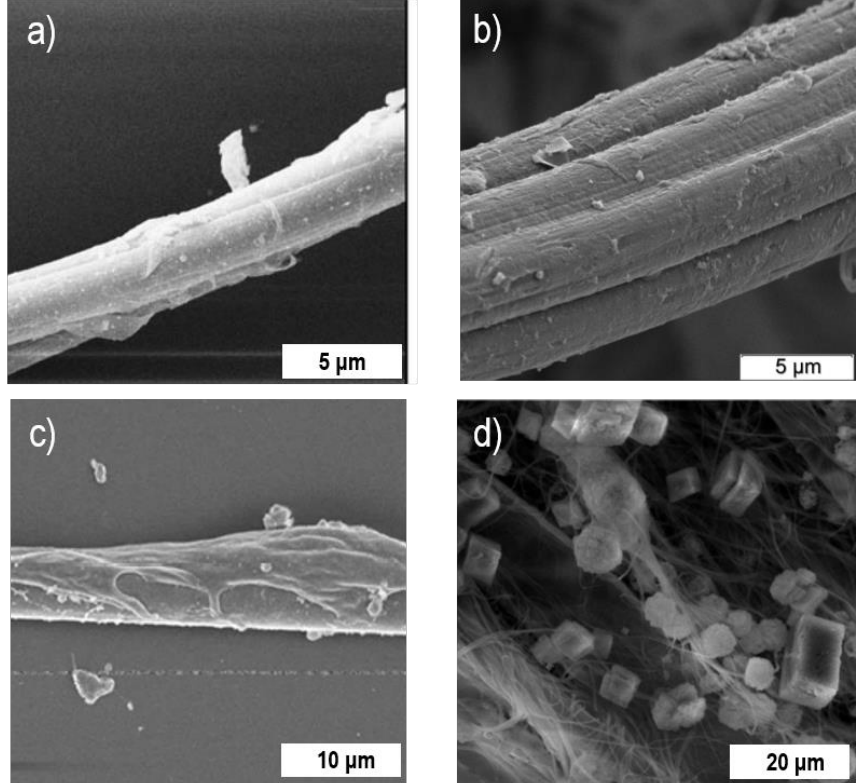
Figure 3. Scanning electron micrographs of spider silk fibers modified with: ( a ) metal nanoparticles (Au) [72], Reproduced with permission from [72]. John Wiley and Sons, 2007. ( b ) metal oxide nanoparticles (ZrO 2 ) [84], Reproduced with permission from [84]. PNAS, 2008. ( c ) carbon nanomaterials (carbon nanotubes) [103], Reproduced with permission from [103]. American Chemical Society, 2018. ( d ) inorganic salts (CaCO 3 ) [99].